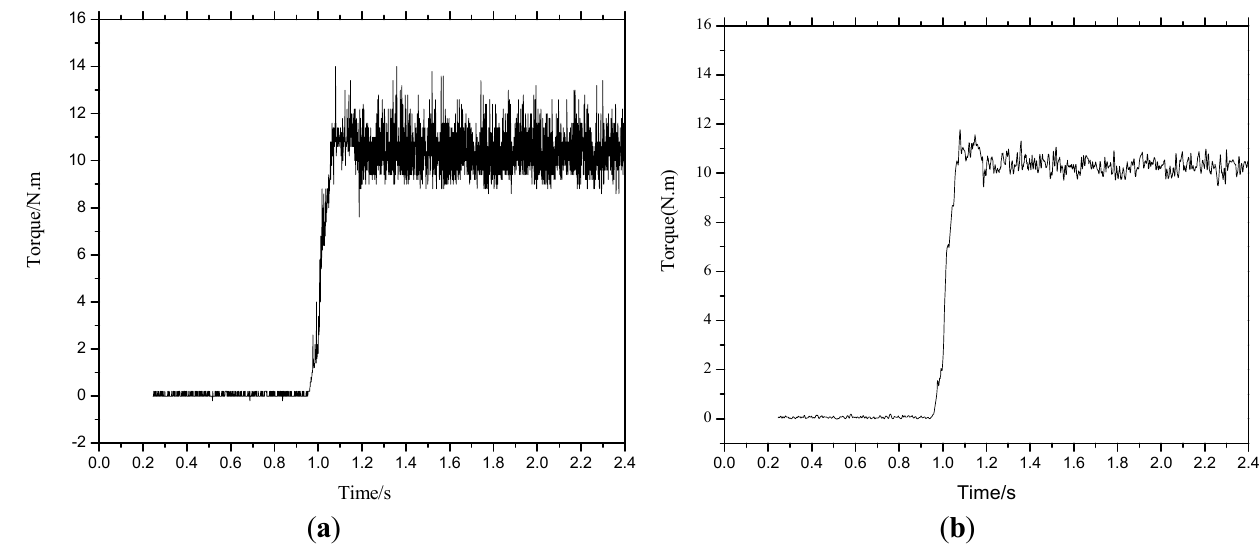
Figure 7. Time response of the output torque when using different controller at T and n = 200 rpm: ( a ) conventional proportional-integral (PI) controller; and ( b ) proposed sliding mode controller.